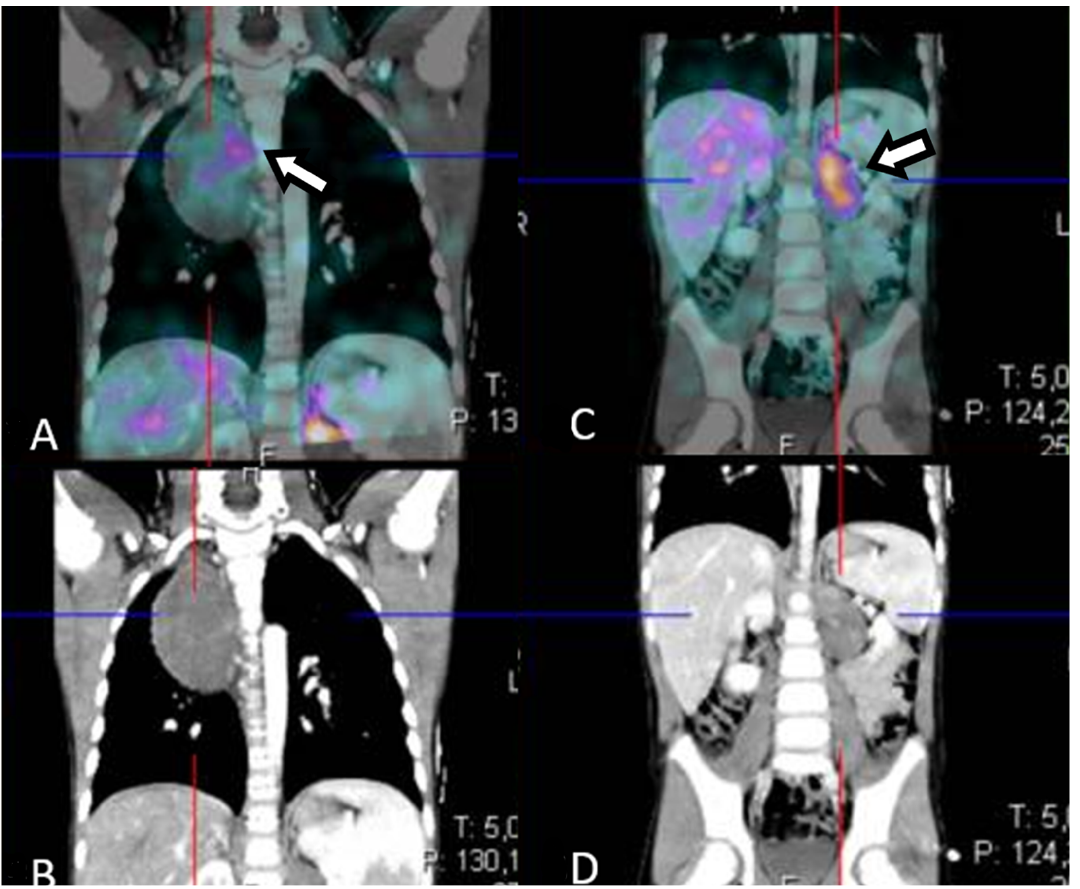
Figure 3. Scintigraphy with 123 I- meta-iodobenzylguanidine ( 123 I-MIBG) scan at baseline. To stage the tumor, a 123 I-MIBG scan was performed, showing diffuse slight uptake in the thoracic mass ( A , B )